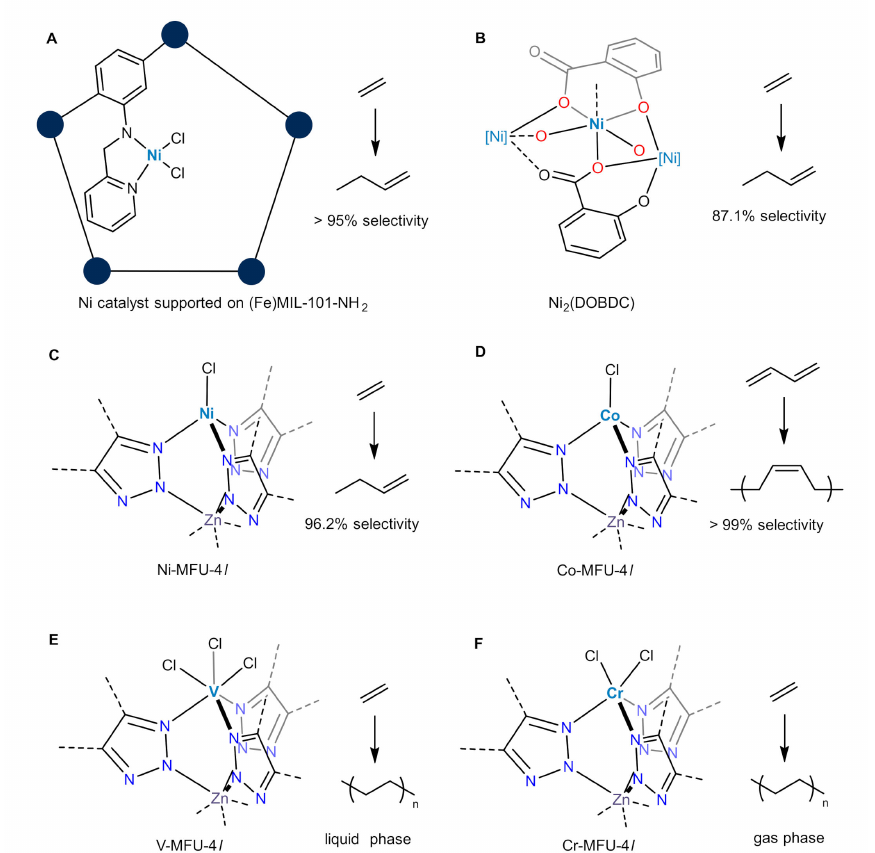
Figure 3. Proposed structure in literature for single-site metal catalysts for olefin polymerization, including ( A ) Ni catalyst supported on Fe-MIL-101-NH 2 , ( B ) Ni 2 (DOBDC), ( C ) Ni-MFU-4 l , ( D ) Co-MFU-4 l , ( E ) V-MFU-4 l , and ( F ) Cr-MFU-4 l